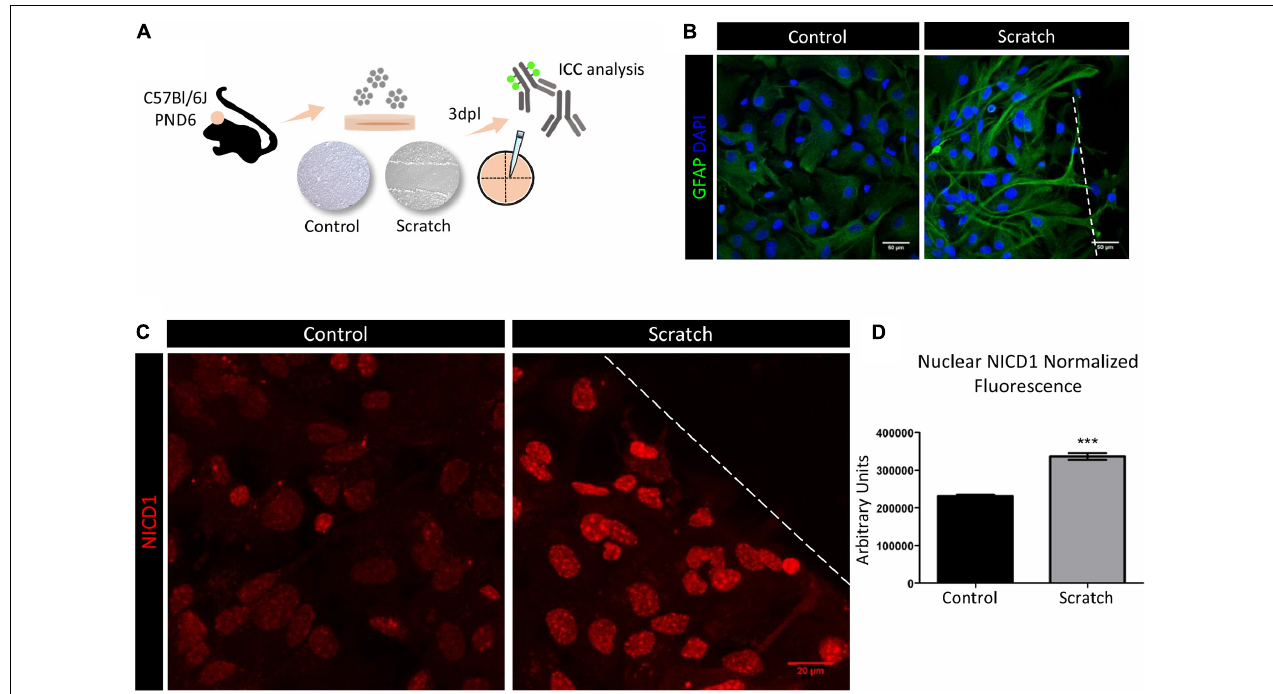
FIGURE 1 | Notch1 signaling is activated in reactive astrocytes in vitro . (A) Experimental design: astrocytes were isolated from the cortex of postnatal day six (PND6) C57BL/6J mice and cultured until confluency in 13 mm coverslips. Astrocyte reactivity was induced by scratch assay, and expression of the reactivity marker GFAP was analyzed 3 days post lesion (3dpl) by immunocytochemistry and confocal imaging. (B) Scratch-induced astrocytes are GFAP + and show reactive morphology. Scale bar: 50 µ m. (C) Representative confocal images of NICD1 staining in control and reactive astrocytes. Dashed line indicates the scratch border. Scale bar: 20 µ m. (D) Normalized fluorescence analysis of nuclear NICD1 immunostaining revealed increased NICD1 nuclear localization in reactive astrocytes compared to control (*** p ≤ 0.001); unpaired Student’s t -test, n = 154 nuclei in scratch / 217 nuclei in control, three culture replicates. Data are mean ± SEM. Nuclei were stained with 4’,6-diamidino-2-phenylindole (DAPI;